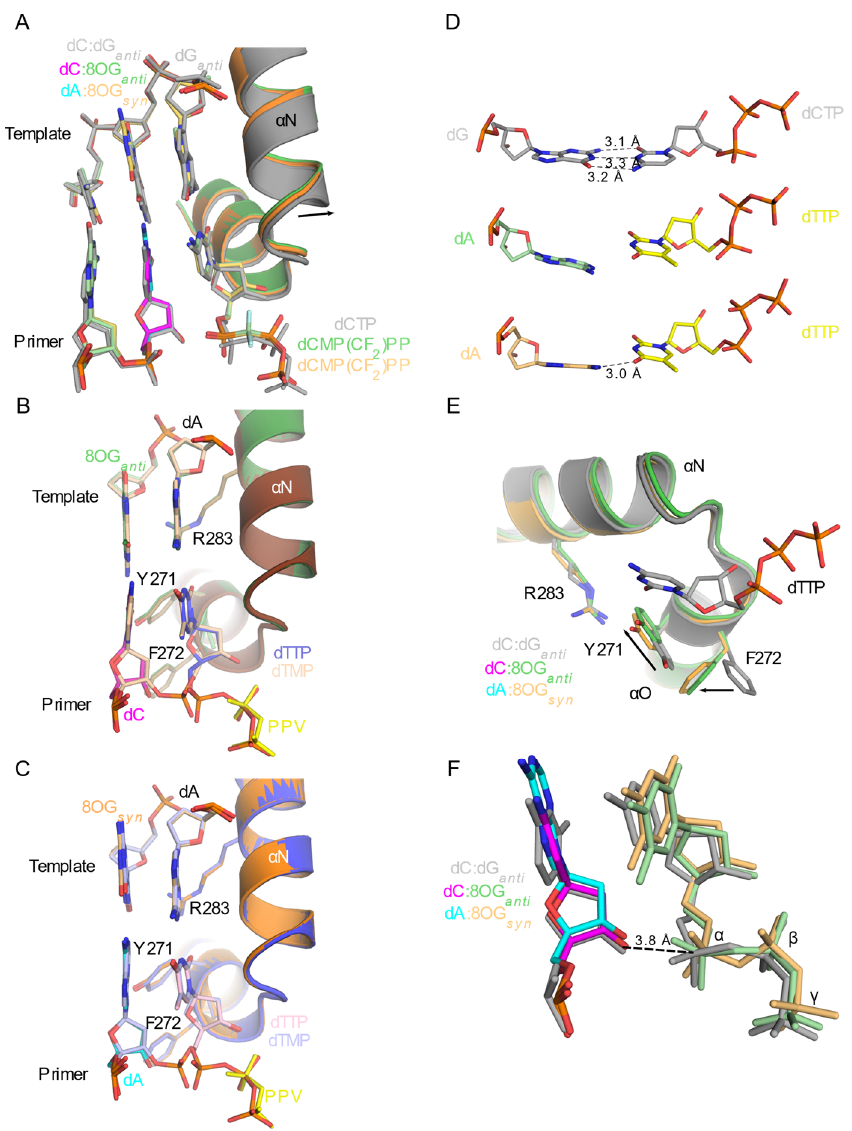
Figure 6. Extension from a template 8OG opposite the primer terminus by Polβ. ( A ). Superposition of Polβ pre-catalytic ternary complex structures containing an undamaged (dG, gray) or oxidized template 8OG (green or khaki) opposite the primer terminus (gray for dCMP:dG, PDB ID code 4KLD [32]; magenta for dCMP:8OG anti , PDB ID code 3RJK [54]; cyan for dAMP:8OG syn , PDB ID code 3RJH [54]) and an incoming cytidine nucleotide opposite the undamaged dG templating nucleotide in the nascent base pair binding site. Secondary structural elements are shown in cartoon representation, and key active site components are drawn in stick. ( B ). Superposition of the pre- (protein and DNA in green, incoming dTTP in slate blue, PDB ID code 5VRX [57]) and post-catalytic (protein in brown, DNA in wheat, pyrophosphate leaving group in yellow, PDB ID code 5VS0 [57]) complexes. The template 8OG lies at the −1 position, adopting the anti conformation opposite the primer terminal dC (magenta in pre-catalytic structure). ( C ). Superposition of the pre- (protein in orange and DNA in orange, incoming dTTP in light pick, PDB ID code 5VS2 [57]) and post-catalytic (protein in slate blue, DNA in light blue, pyrophosphate leaving group in yellow, PDB ID code 5VS4 [57]). The template 8OG lies at the −1 position, adopting the syn conformation opposite the primer terminal dA (cyan in pre-catalytic structure). ( D ). Comparison of the nucleotides in the nascent base pair binding pocket in the dC:dG reference structure (PDB ID code 4KLD [32], gray, top) versus those of the nonplanar dTTP:dA conformations with either primer terminal dC:8OG anti (PDB ID code 5VRW [57], middle) or dA:8OG syn (PDB ID code 5VS1 [57], bottom). Hydrogen bonds are indicated by black dashed lines. Comparison of Polβ active site residue positions ( E ) and incoming nucleotide geome- try ( F ) in the undamaged reference structure (PDB ID code 4KLD [32], gray) versus those containing